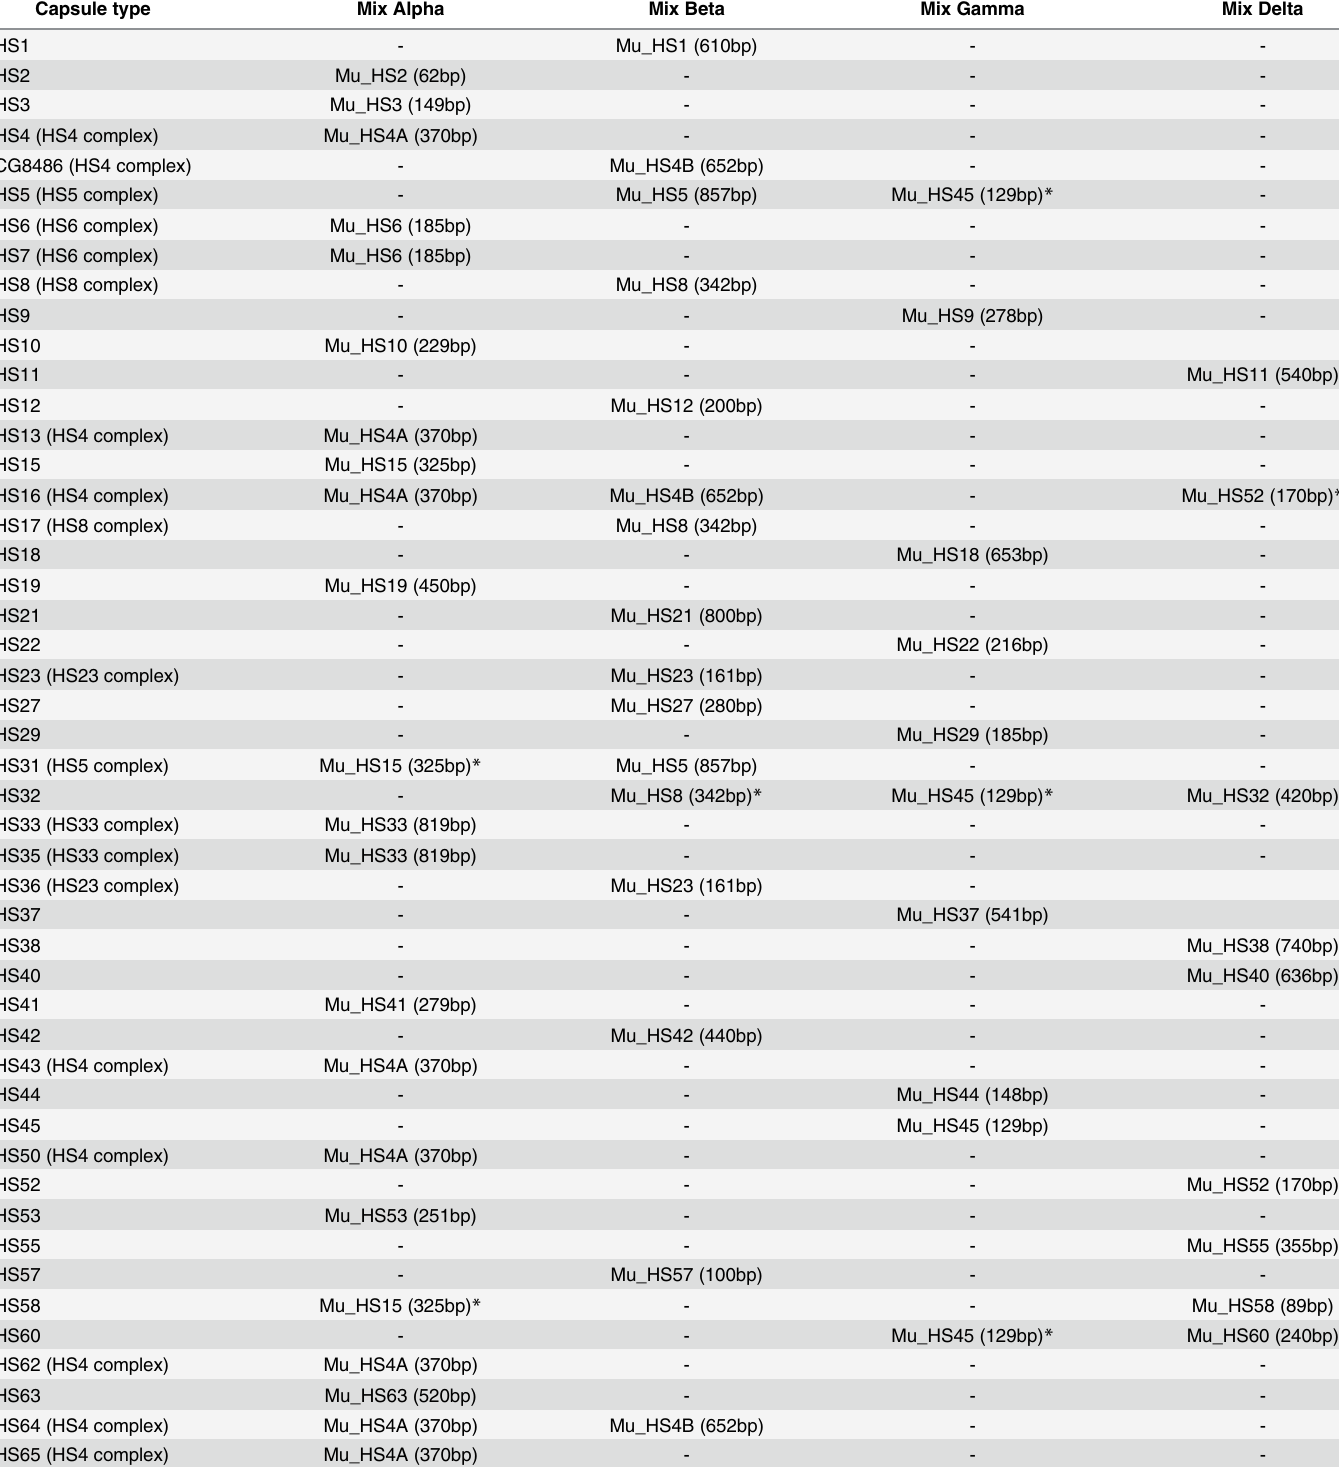
Table 4. Summary of the C . jejuni capsule multiplex PCR expected